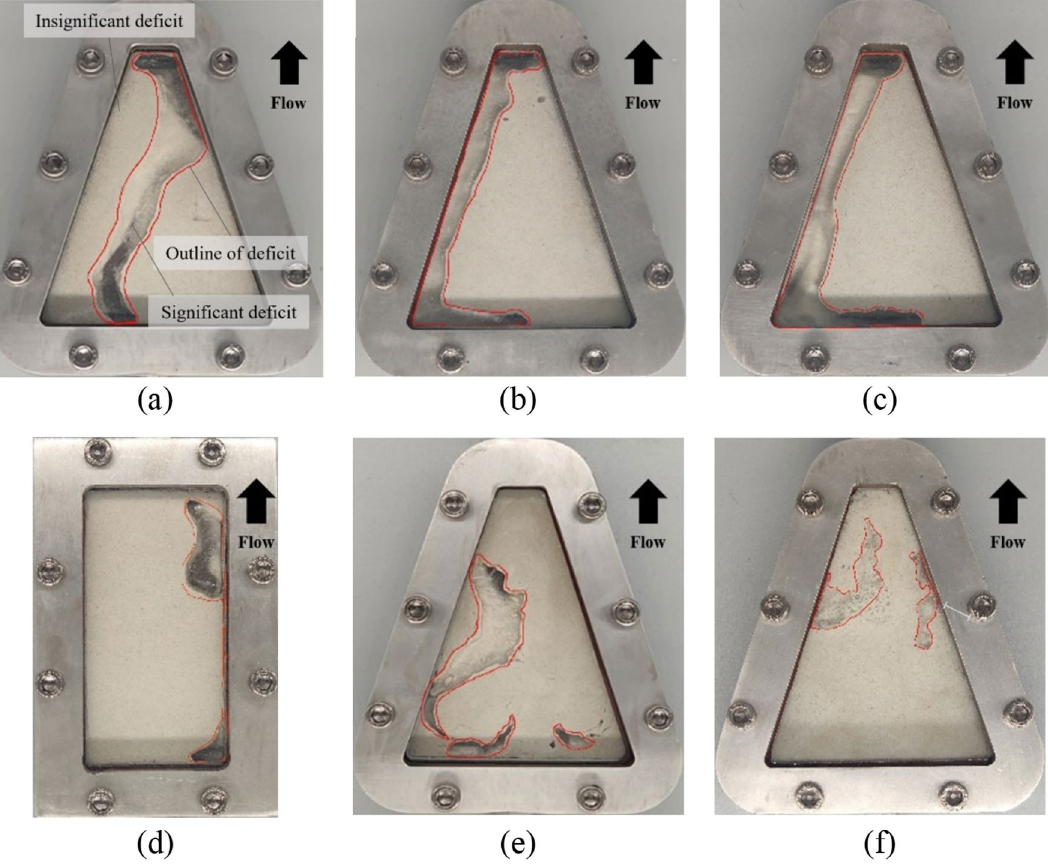
Fig. 5 Single-branch wormhole sanding cavity in different uniaxial compressive strength samples. a UCS of 0.018 MPa; b UCS of 0.029 MPa; c UCS of 0.202 MPa; d UCS of 0.202 MPa; e UCS of 0.703 MPa; and f UCS of 1.189